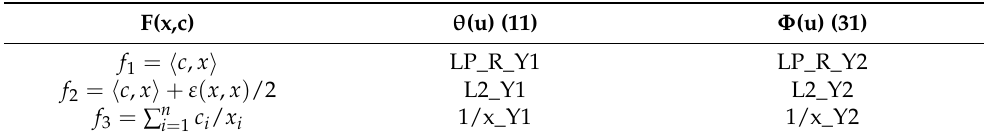
Table 1. Test functions and their